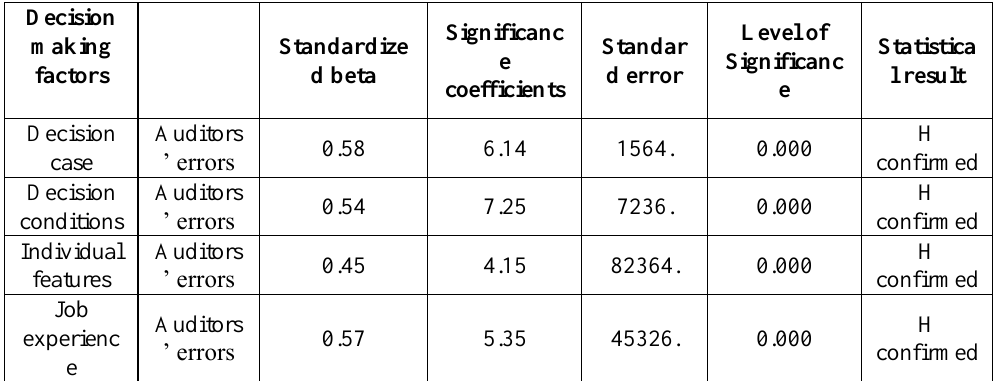
Table (3) Role relationship path analysis test for varieties of decision making over auditors’ errors based on standardized coefficients and